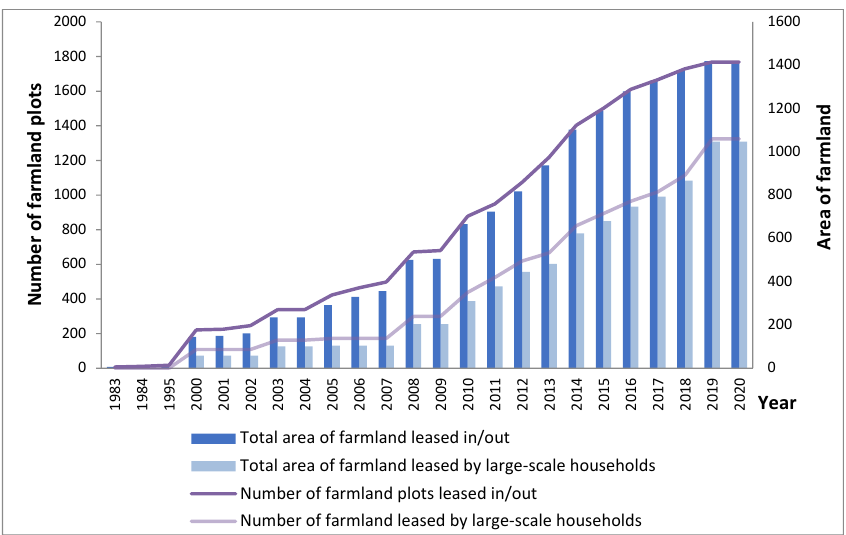
Figure 3. General process of farmland leasing in Huang village.